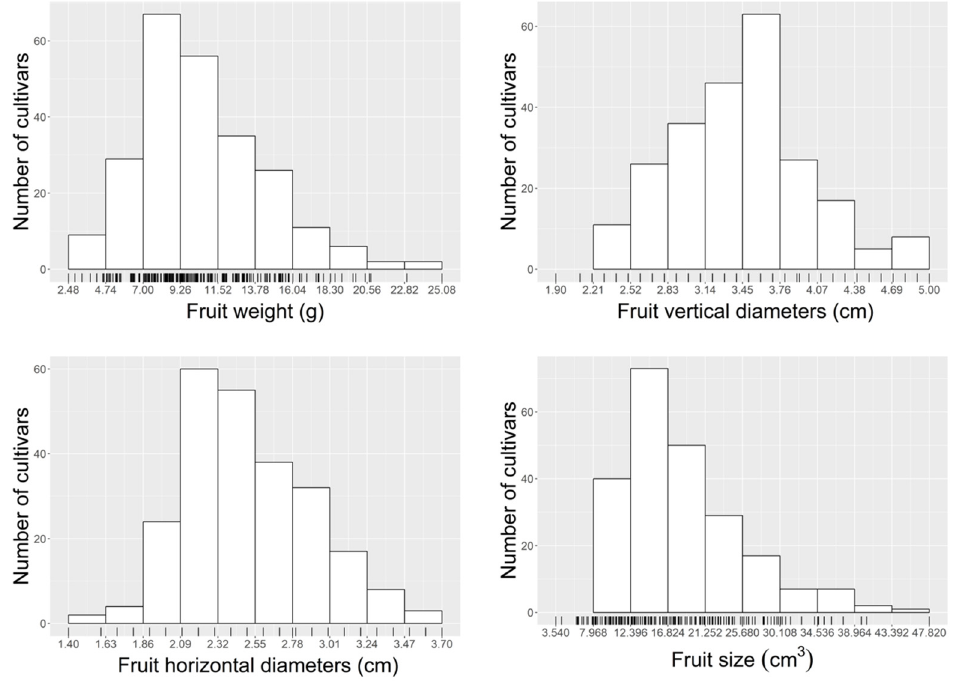
Figure 6. Histogram distribution of four fruit morphological traits of 243 Chinese jujube cultivars.